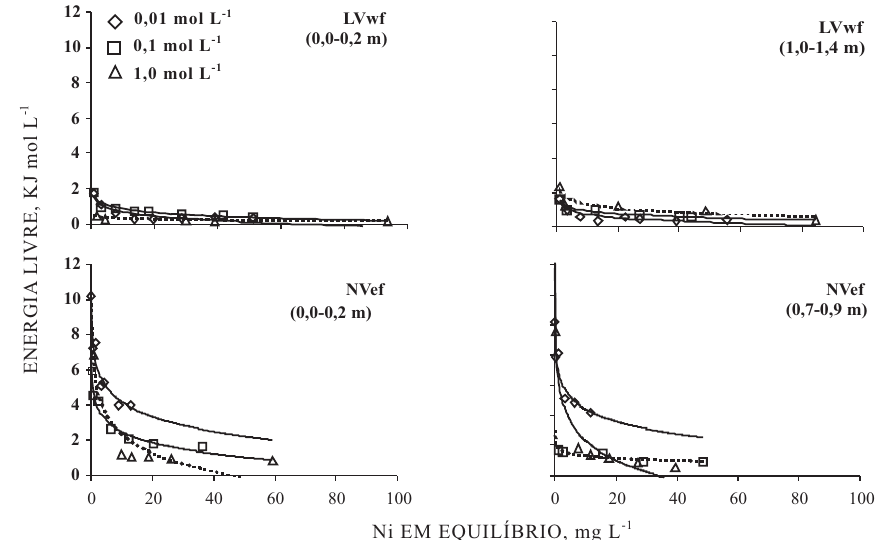
Figura 2. Energia livre da reação de adsorção de Ni para Latossolo Vermelho acriférrico (LVwf) e Nitossolo Vermelho eutroférrico (NVef), coletados em superfície e profundidade, utilizando CaCl iônicas 0,01; 0,1; e 1,0 mol L -1